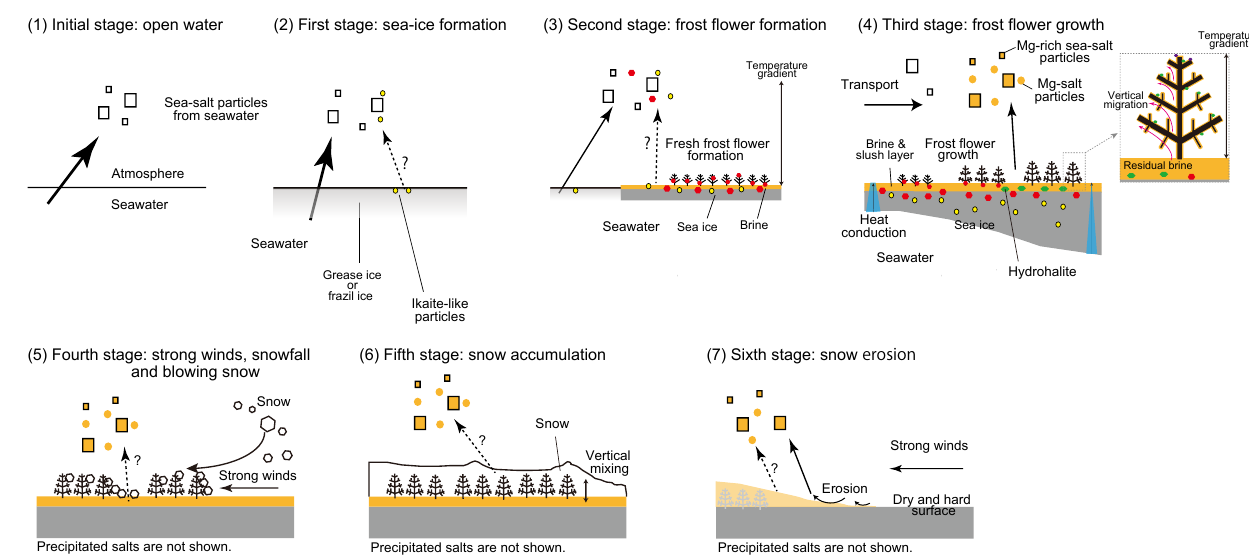
Figure 12. Schematics of sea-salt cycles in the sea-ice area. Dotted arrows indicate the speculated processes.